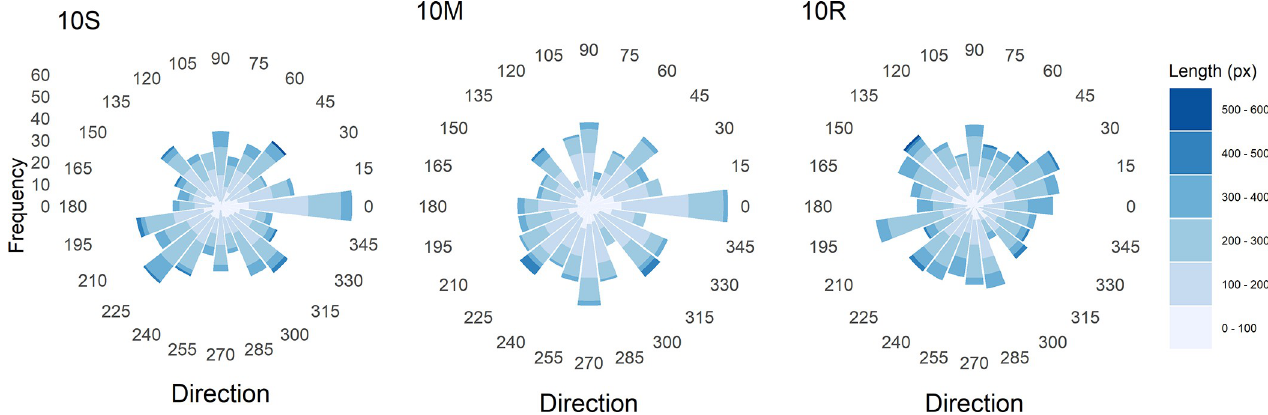
Fig 4. Histograms of direction (in polar coordinates) and length of the paths between successive dots for the two conditions (10S, 10M) in Experiment 1, and for the random-dot pattern (10R).